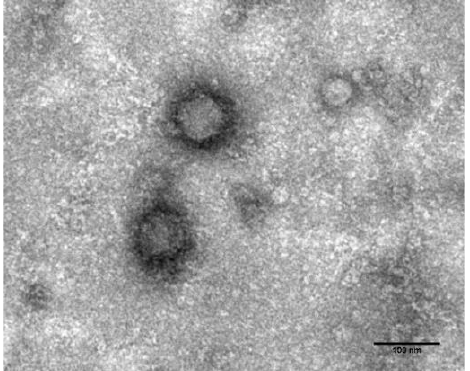
Figure 1. Transmission electron micrographs showing the HPy1R particle morphology, stained with 2% uranyl acetate. Scale bar: 100